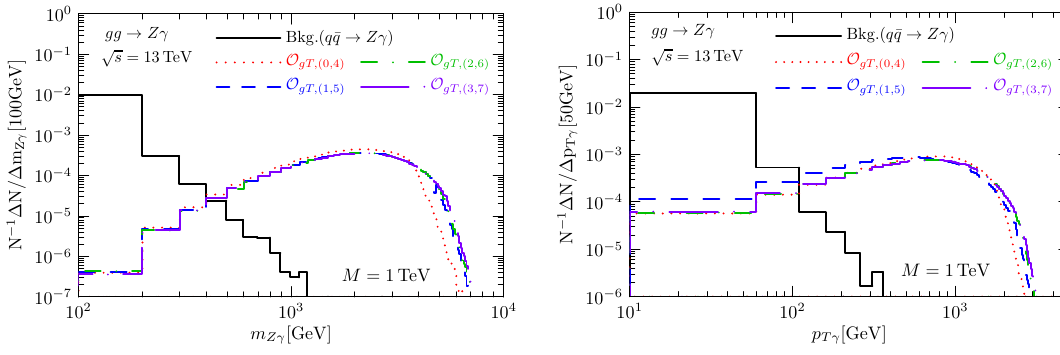
Figure 3 . The normalized event spectra due to the background (black solid line) and gQGC operators (colorful non-solid lines) as functions of the Zγ invariant mass m Zγ (left) and the photon √ transverse momentum p Tγ (right) at the LHC with s = 13 TeV . As seen more clearly in the left panel, the total cross sections have been regulated to respect the unitarity